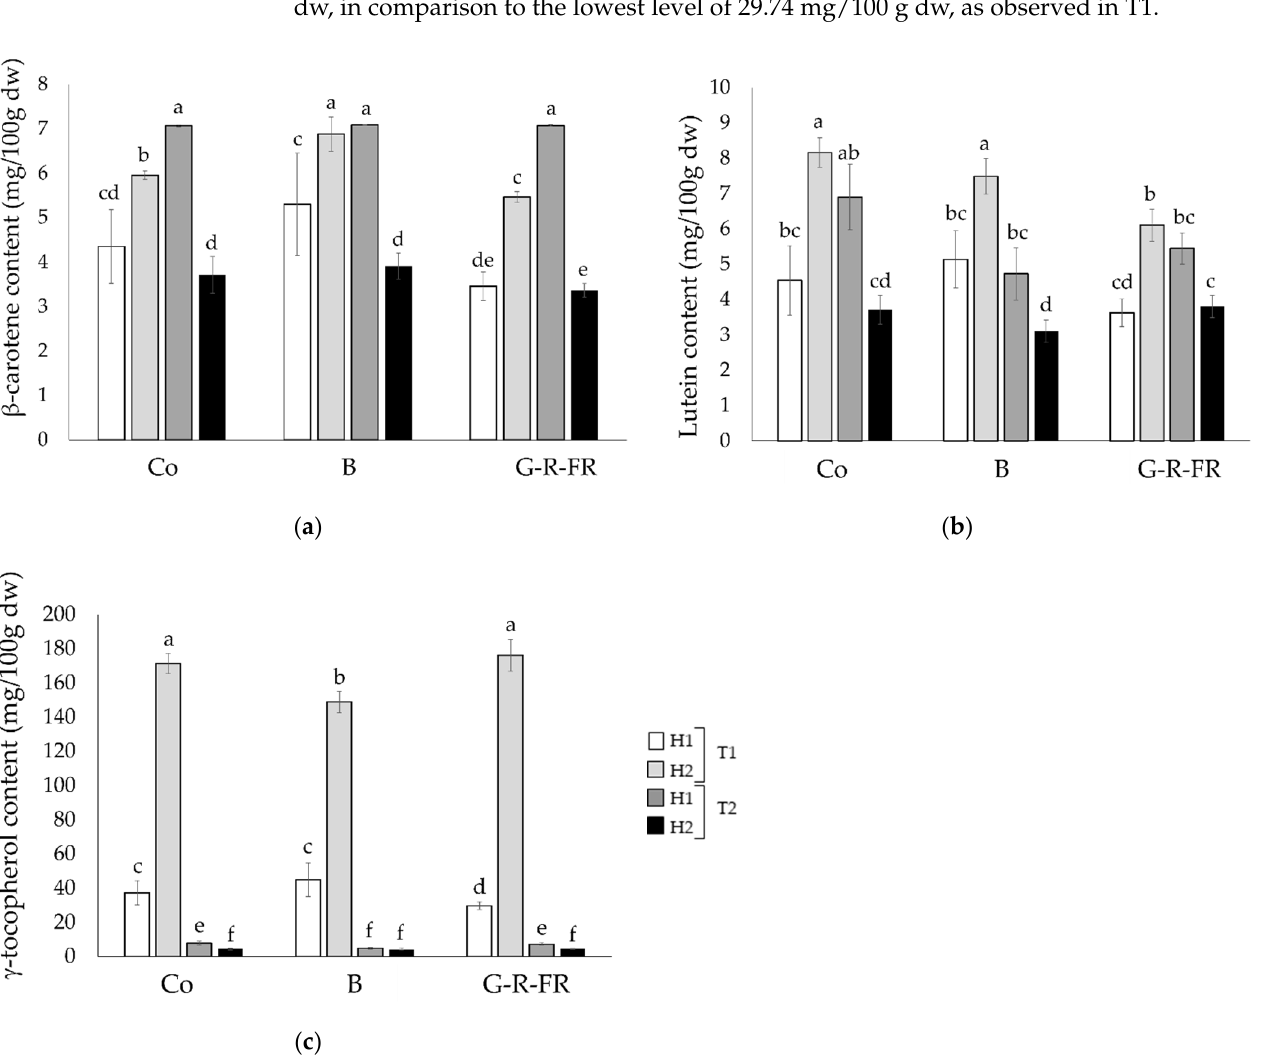
Figure 3. ( a ) Levels of β -carotene, ( b ) lutein, and ( c ) γ -tocopherol were measured in broccoli samples across all harvests and light treatments. The different letters represent significant differences between samples ( p < 0.05).